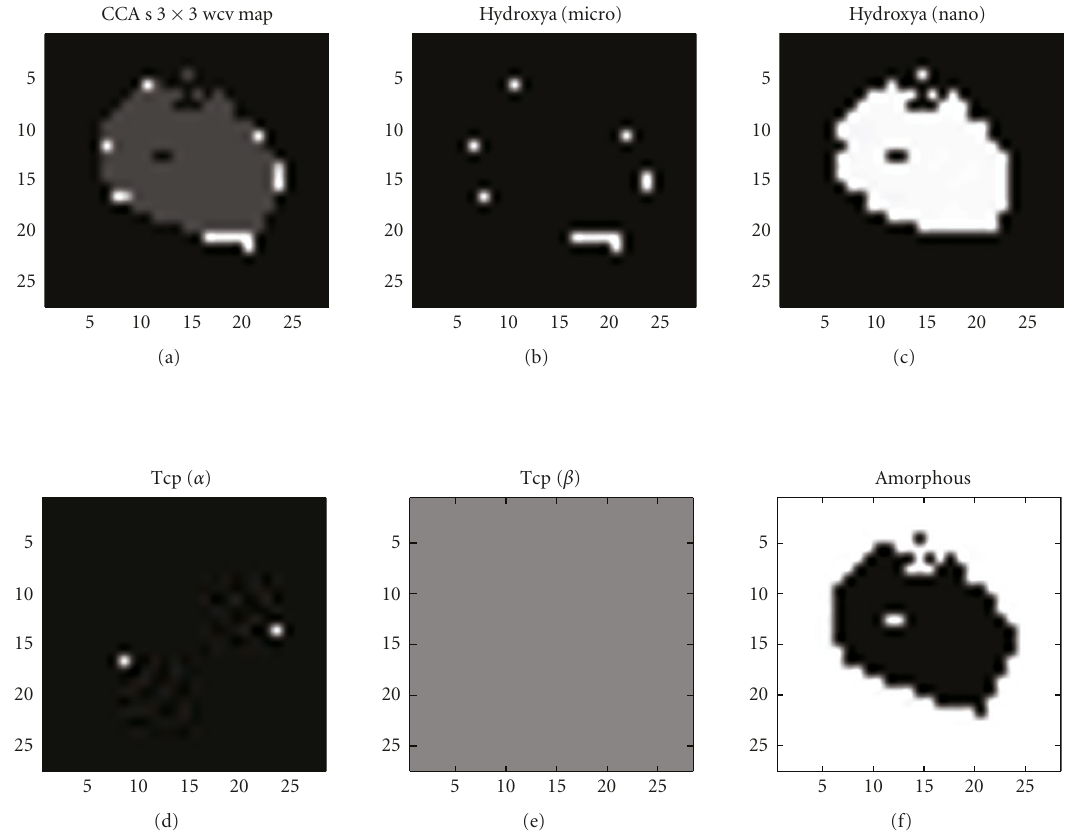
Figure 4: The nosologic image and the correlation maps (white corresponds to highest canonical coe ffi cient) obtained from di ff raction data of Figure 1 by CCA s 3 × 3 wcv (black: amorphous, dark gray: hydroxya (nano), gray: Tcp( α ), light gray: hydroxya (micro)).